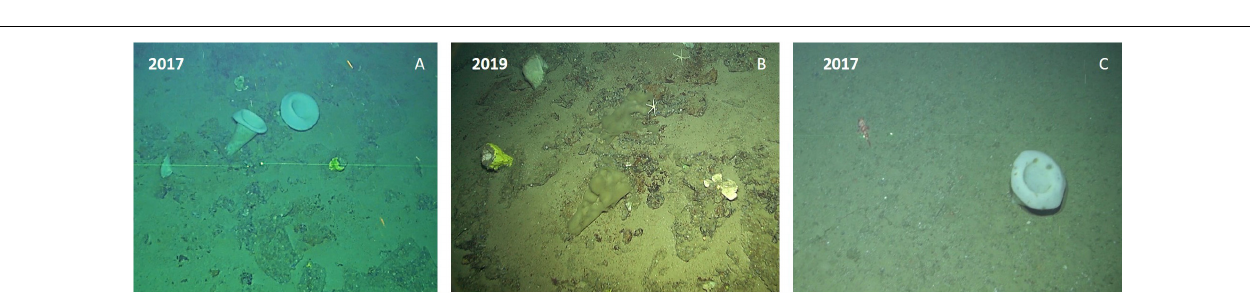
FIGURE 12 | (A) Two A. setubalense specimens recorded in 2017. (B) These specimens appeared dead in 2019. Their biological remains can be observed in the 2019 image. (C) A. setubalense recorded in study zone 2 with brown spots on its